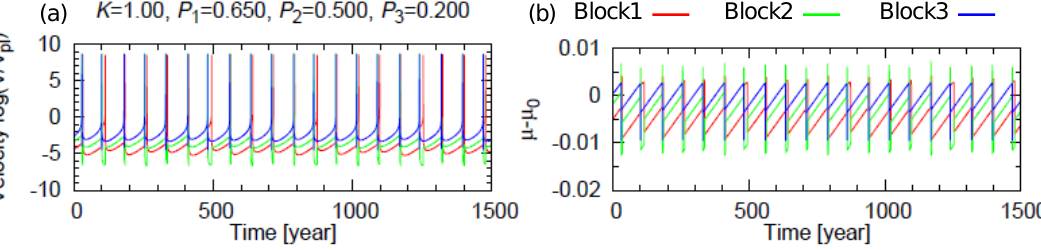
Figure 8. Example histories of (a) V and (b) µ − µ ∗ for pattern 2. The model parameters are set to K = 1 . 00, P 1 = 0 . 650, P 2 = 0 . 500, and P 3 = 0 . 200.